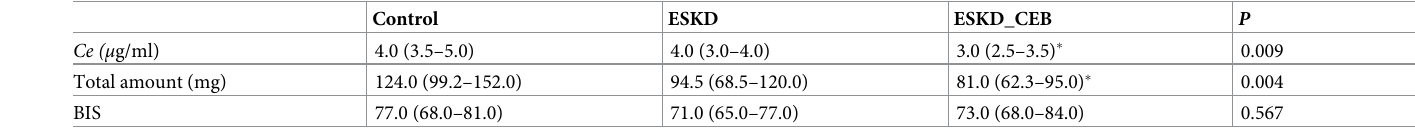
Table 2. Effect-site concentration ( Ce ), total amount of propofol and bispectral index (BIS) at loss of